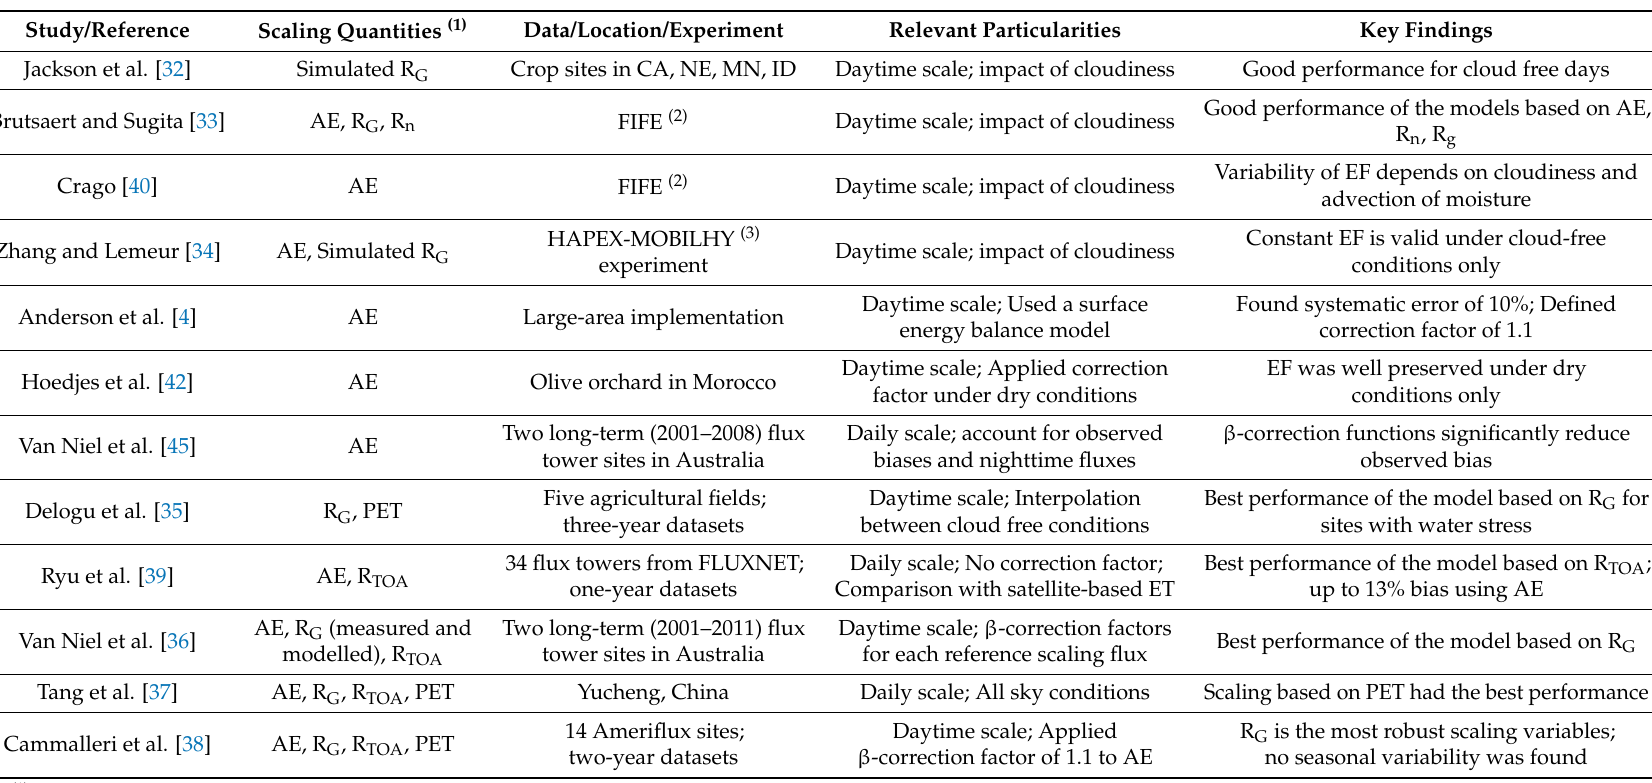
Table 1. Summary of techniques used to upscale evapotranspiration from time-of-day observations to daytime or daily scale. Relevant specifications and key findings are also